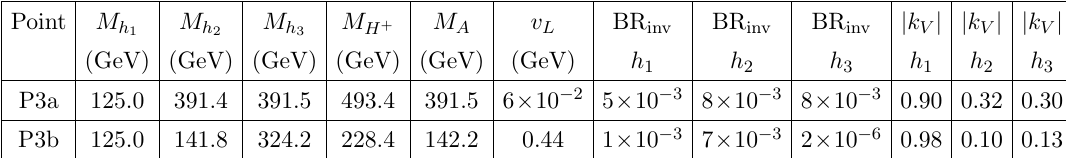
Table 6 . Parameters for points P3a and